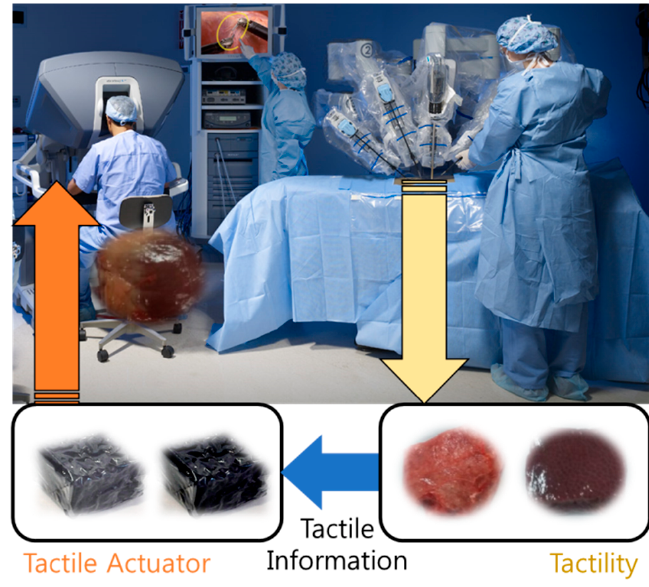
Figure 1. Concept of tactile sensation by the surgeon.